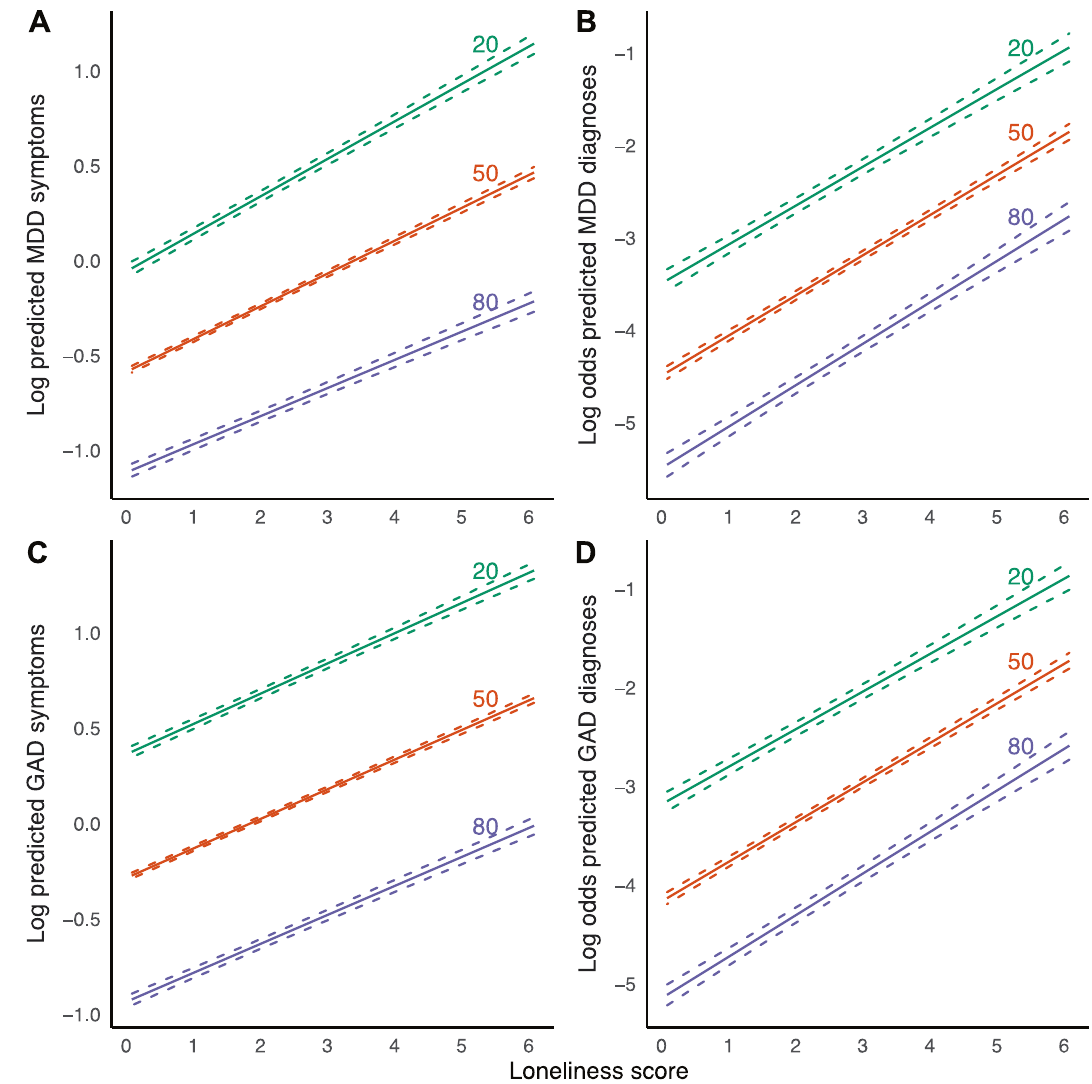
Figure 3. Marginal effect plots of associations between loneliness and MDD and GAD outcomes across age. Displayed are log predicted counts of MDD symptoms ( A ) and log odds of MDD diagnosis ( B ), as well as log predicted counts of GAD symptoms ( C ) and log odds of GAD ( D ), across different loneliness scores, across three levels of age in years (plotted estimates are derived from Tables 2 and 3, main models). Dashed lines represent 95% confidence intervals of model-predicted